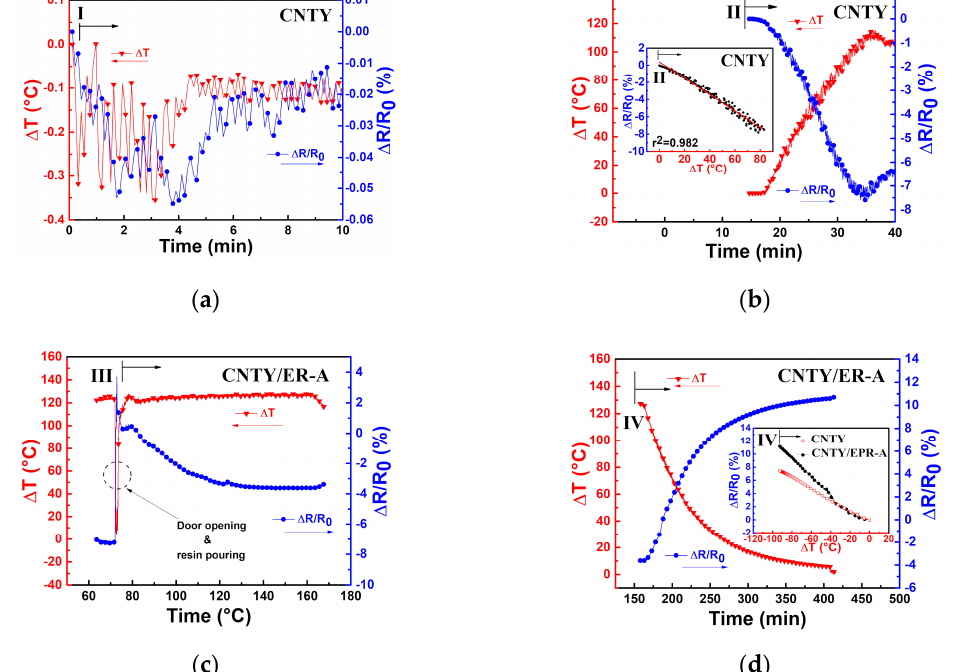
Figure 4. Close-ups of the zones shown in Figure 3 for CNTY/ER-A. ( a ) Zone I (freestanding CNTY), ( b ) heating thermoresistive sensitivity in zone II (freestanding CNTY), ( c ) onset of zone III indicating the moment of resin pouring (CNTY embedded in resin), ( d ) thermoresistive sensitivity in zone IV (CNTY embedded in resin).